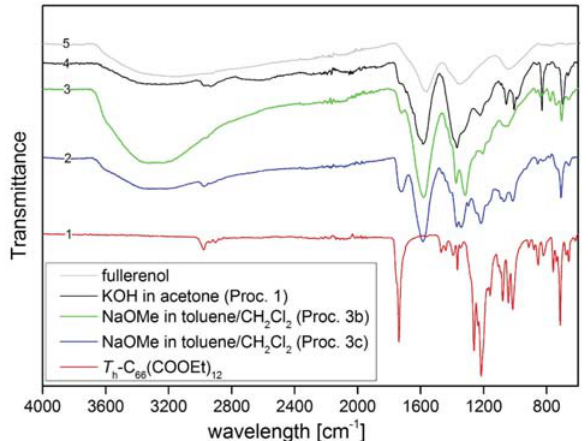
Figure 2. IR spectra of hydrolyzed samples of T different conditions, together with the spectrum of the parent